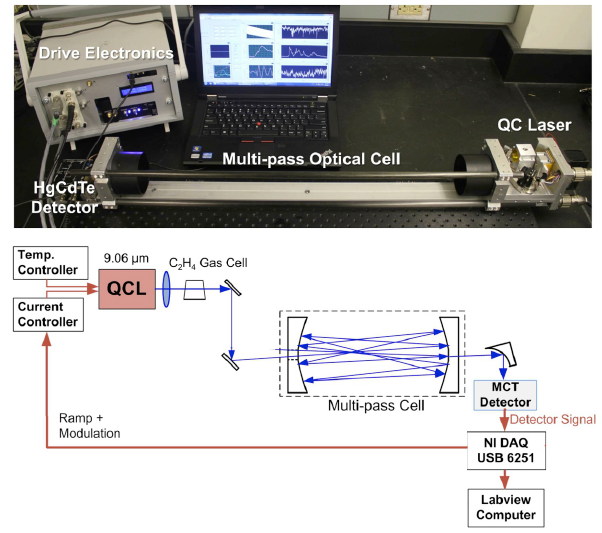
Fig. 1. Open-path atmospheric NH 3 sensor with drive electronics Figure 1. Open-path atmospheric NH 3 sensor with drive electronics (top) and sensor 2 (top) and sensor schematic schematic (bottom). 3